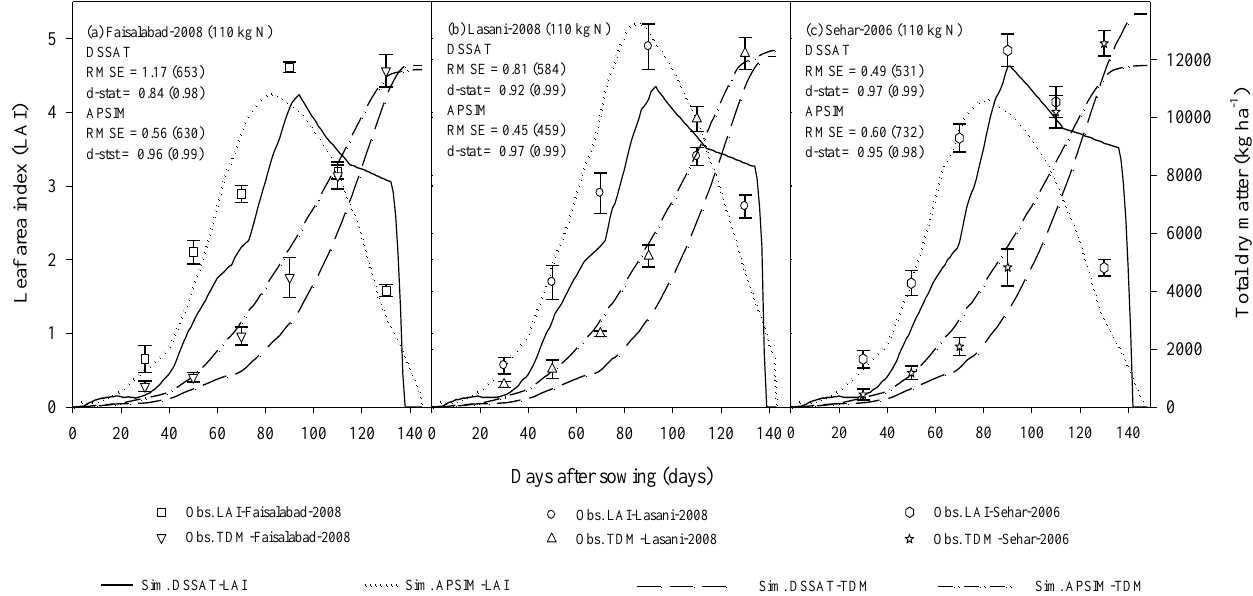
Figure 3. Simulated and observed time course leaf area index and total dry matter of wheat cultivars, Faisalabad-2008 ( a ), Lasani-2008 ( b ) and Sehar-2006 ( c ) for DSSAT (CERES) and APSIM models calibration for year 2008 – 2009.